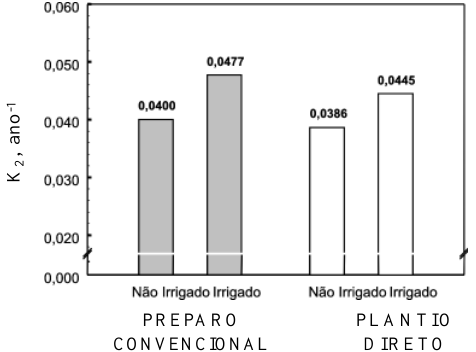
Figura 2. Taxas de decomposição da matéria orgânica do solo ( k ) estimadas para o solo 2 submetido aos sistemas de manejo, preparo convencional e plantio direto, com e sem irrigação por